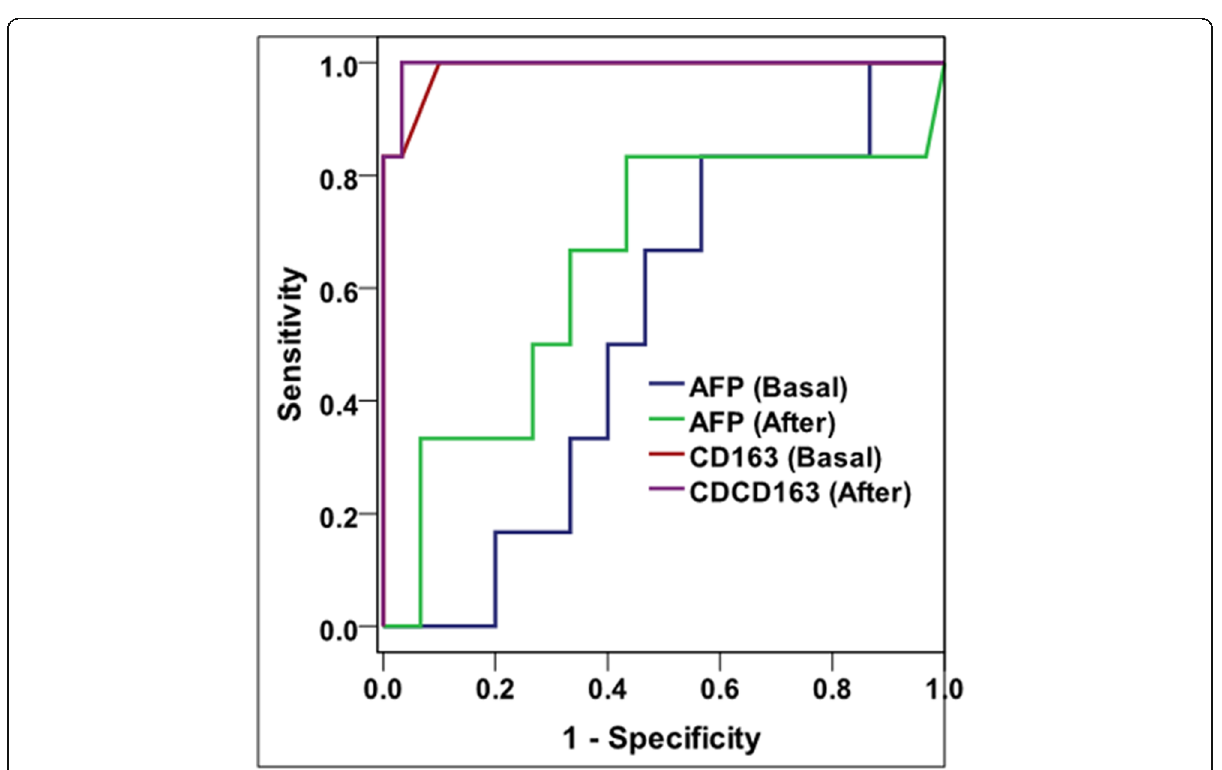
Fig. 2 ROC curve showing comparison of the diagnostic performance of pre- and post-intervention sCD163 and AFP in differentiating recurrent from eradicated HCC